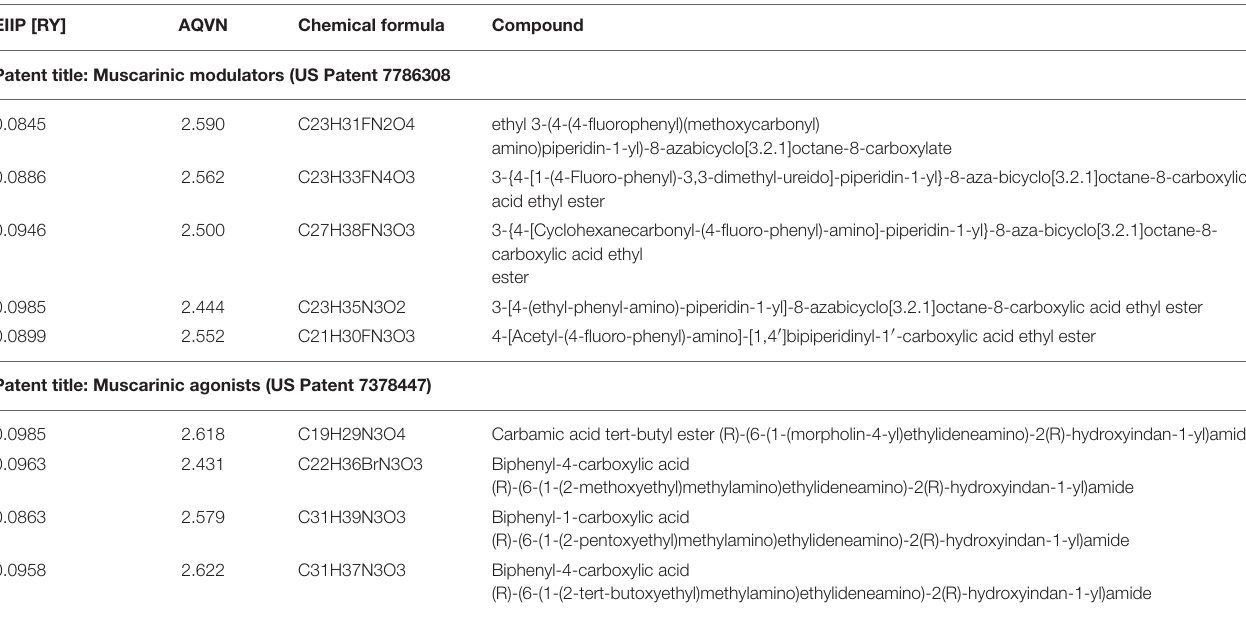
TABLE 1 | EIIP/AQVN values of patented muscarinic modulators: Muscarinic modulators (US Patent 7786308), Muscarinic agonists (US Patent 7378447), and Modulators of muscarinic receptors (US Patent Application 20100311746A1). EIIP